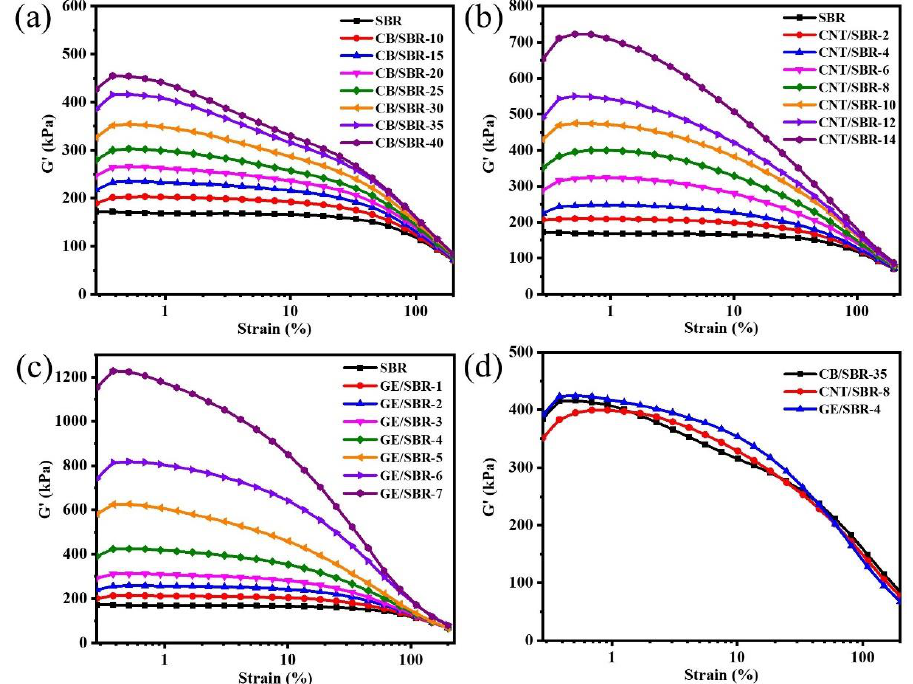
Figure 3. Storage modulus versus dynamic strain of SBR compounds filled with different contents of ( a ) CB; ( b ) CNTs and ( c ) GE; ( d ) storage modulus versus dynamic strain of CB / SBR-35, CNTs / SBR-8, and GE / SBR-4 compounds.